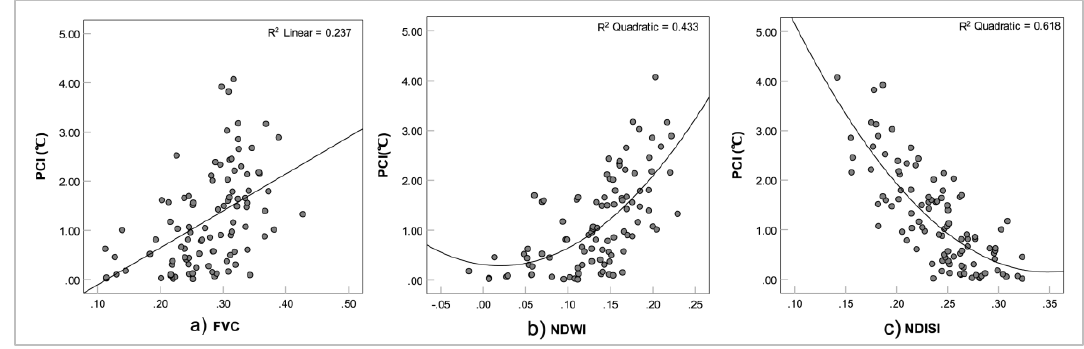
Figure 5. Regression analysis of park PCI and ( a ) mean FVC; ( b ) mean NDWI; ( c ) mean NDISI.